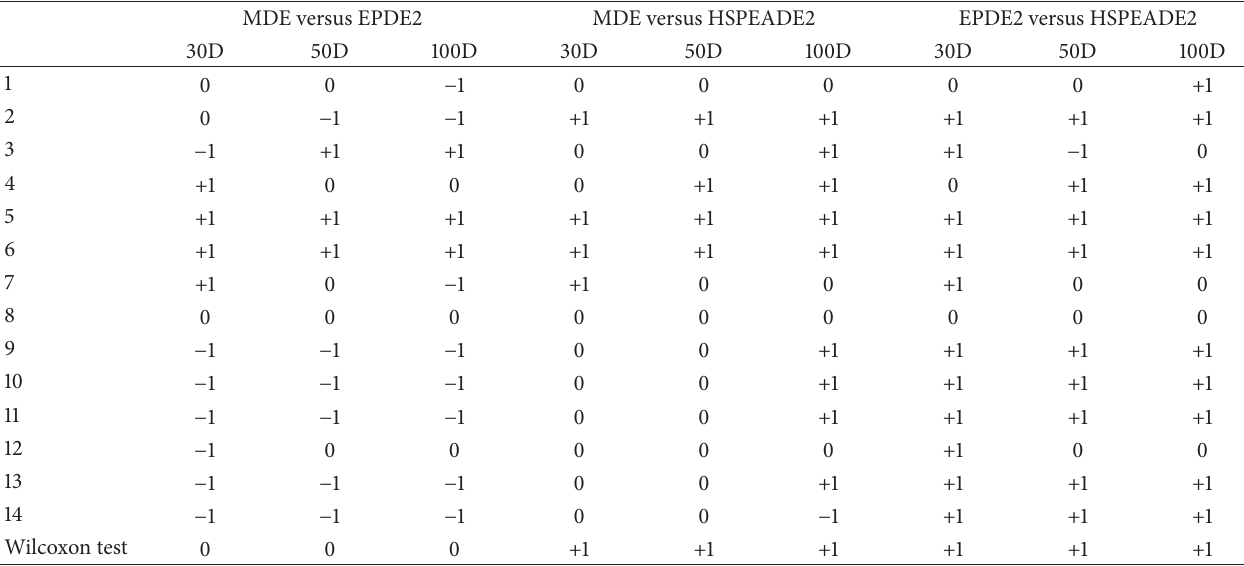
Table 8: Statistical test results to compare the performance of MDE, EPDE2, and